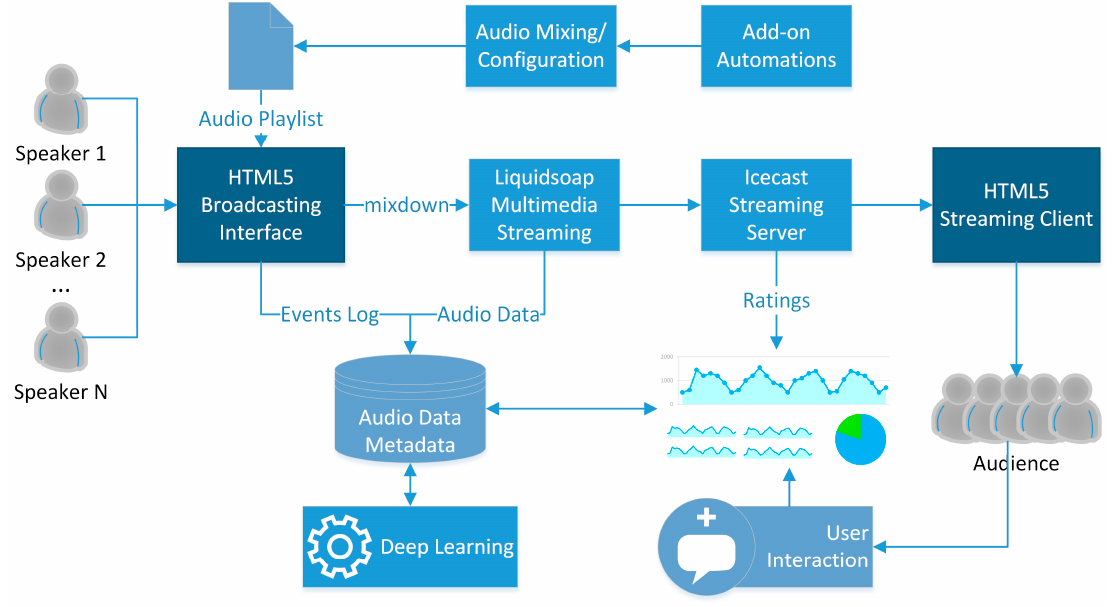
Figure 4. The architecture of the web application for web radio production, streaming, and annotation.